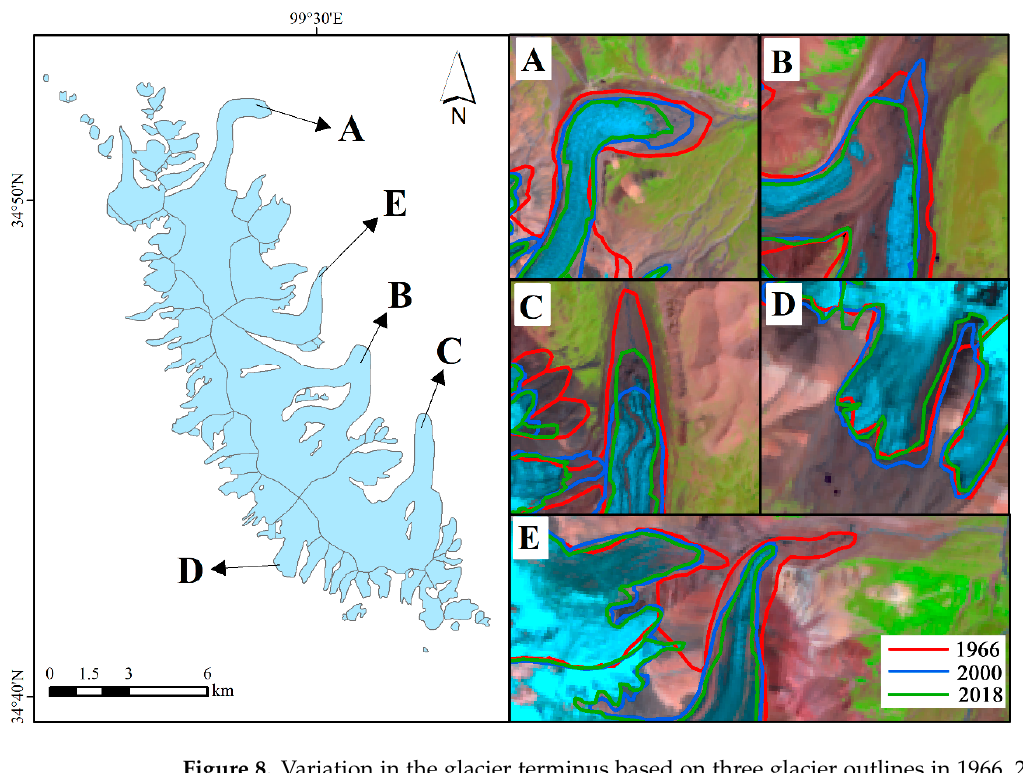
Figure 8. Variation in the glacier terminus based on three glacier outlines in 1966, 2000, and 2018. (A, Weigeledangxiong Glacier; B, Halong Glacier; C, Yehelong Glacier; D, No. 5J351D0001 Glacier; E, No. 5J351D0022 Glacier.). (( A ), Weigeledangxiong Glacier; ( B ), Halong Glacier; ( C ), Yehelong Glacier; ( D ), No. 5J351D0001 Glacier; ( E ), No. 5J351D0022 Glacier.).